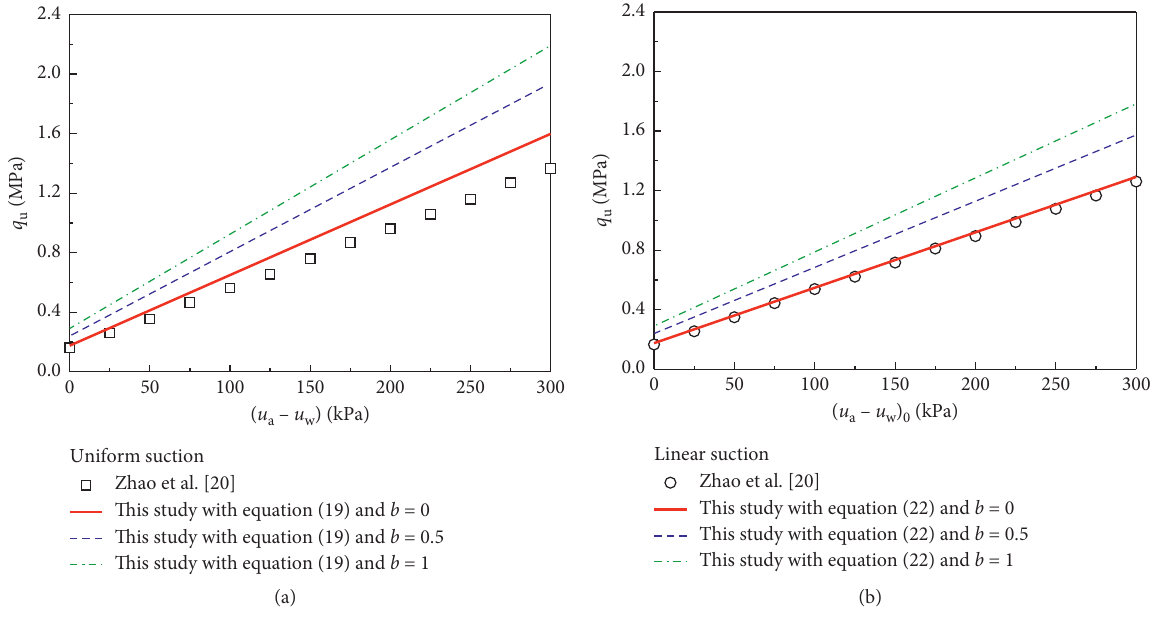
Figure 7: Comparisons with the result of Zhao et al. [20]. (a) Uniform suction. (b) Linear suction.